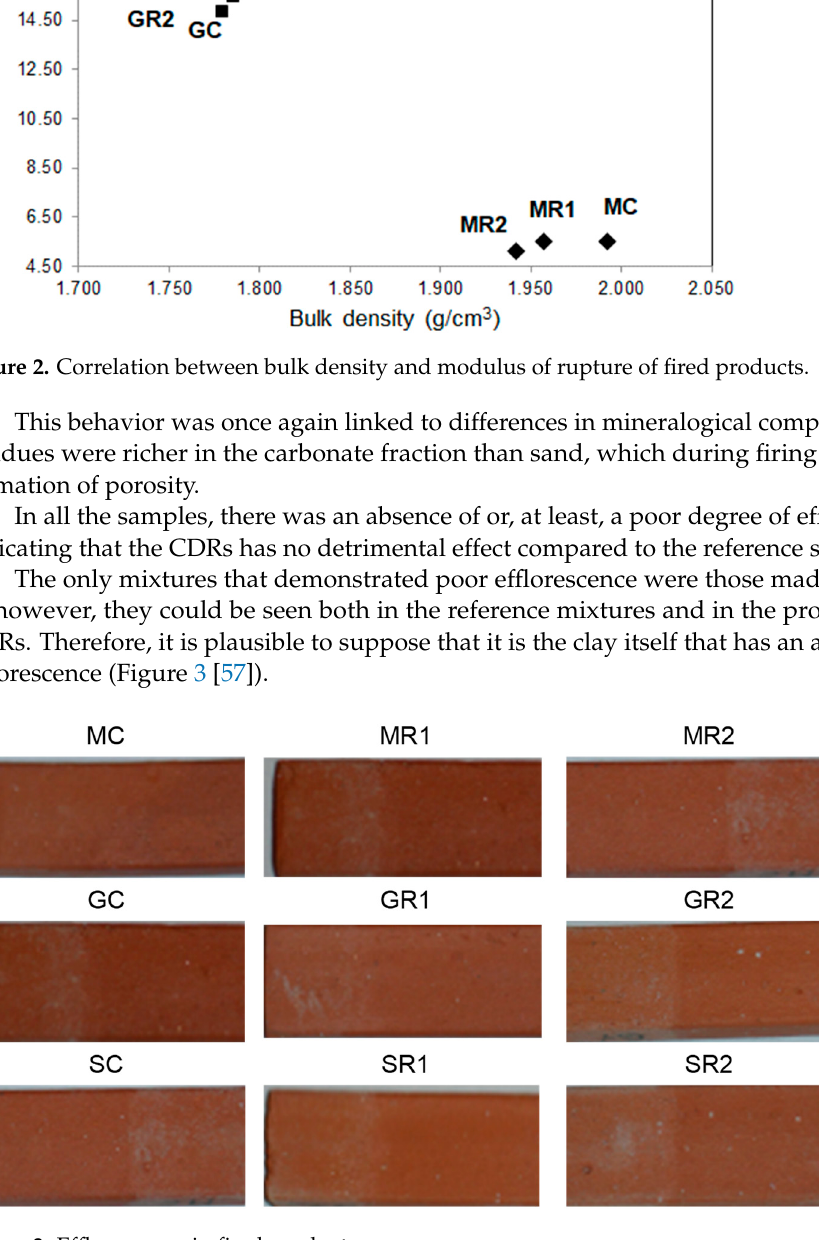
Figure 3. Efflorescence in fired products.